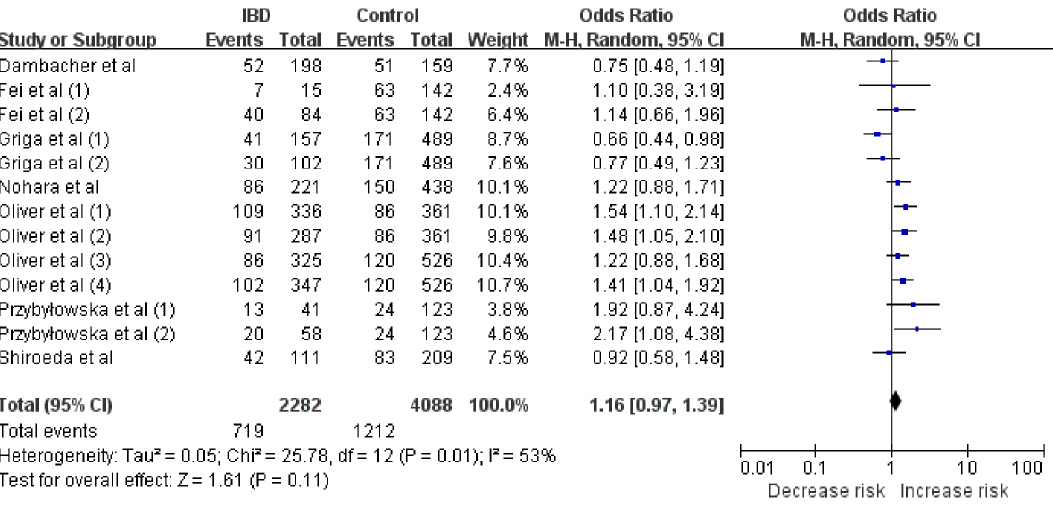
Figure 2. Meta-analysis using a random-effects model to evaluate the association between the MIF -173 G/C polymorphism and IBD risk (CC + CG vs. GG). The size of the square is proportional to the weight of each study; horizontal lines represent the 95%